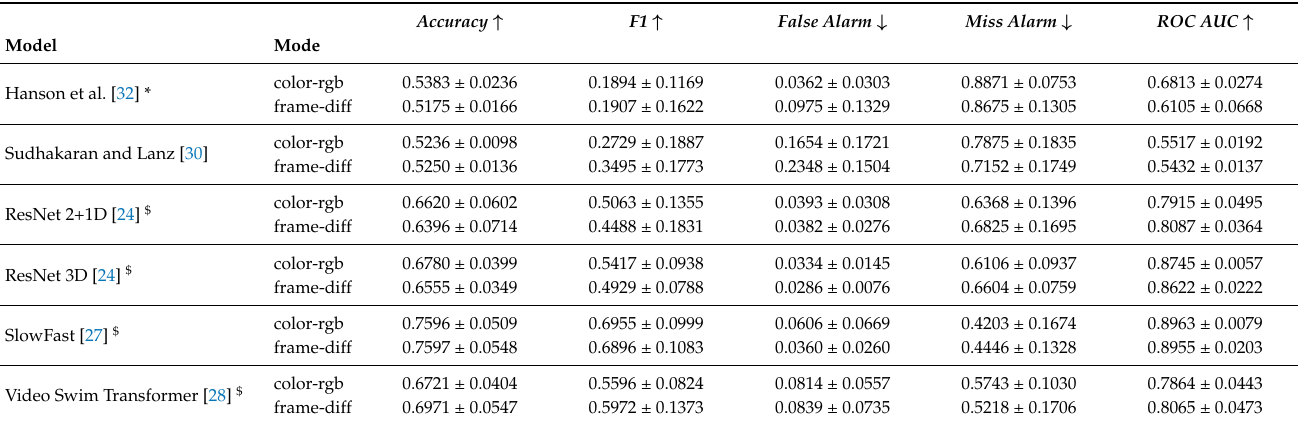
Table 3. Cross-dataset evaluation (pre-training on Surveillance Camera Fight [21] dataset, test on our Bus Violence dataset).